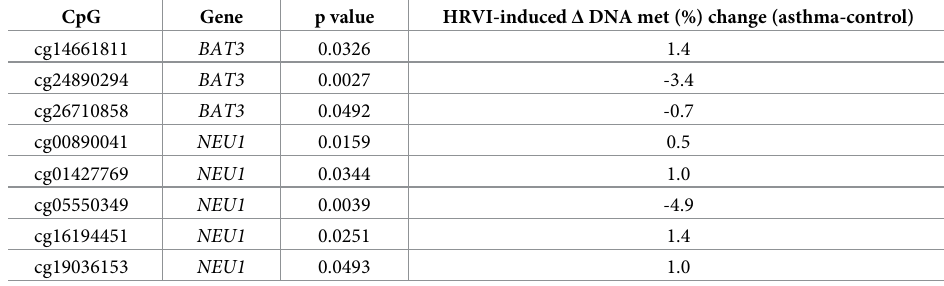
Table 4. CpGs with RIDM in BAT3 and NEU1 in children with